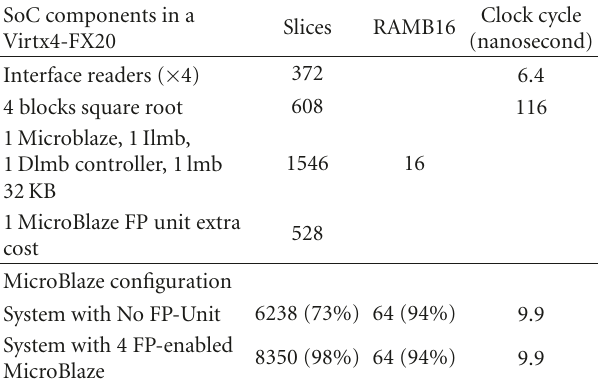
Table 2: Implementation results, area resources and performance of a 4-MicroBlaze SoC and analysis breakdown to the critical blocks; if longer processing times are a ff ordable a less costly solution can be a 4-MicroBlaze SoC without a floating-point unit.